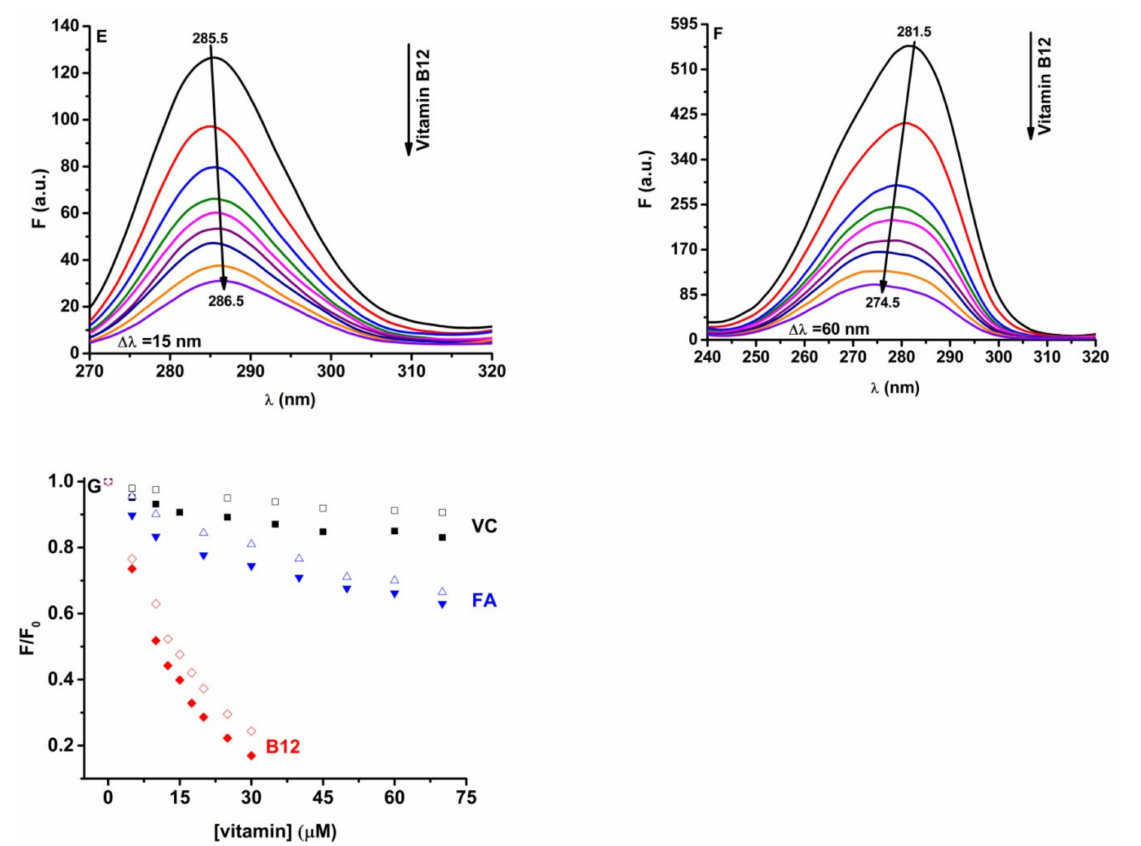
Figure 6. Synchronous fluorescence spectra of BSA-LT4 in the presence of different concentrations of vitamin C, folic acid, and vitamin B12 ( ∆ λ = 60 nm and ∆ λ = 15 nm) The significance of the colors is explained by the arrow in the figure that indicates the direction of increase of the concentration of each compound in the 3 situations ( A – F ). Quenching of BSA-LT4 synchronous fluorescence by vitamins plotted as the quenching of BSA synchronous fluorescence (F/F0) by vitamin concentrations ( G ): empty symbols correspond to ∆ λ = 15 nm and full symbols correspond to ∆ λ = 60. The name of the compound is next to the corresponding